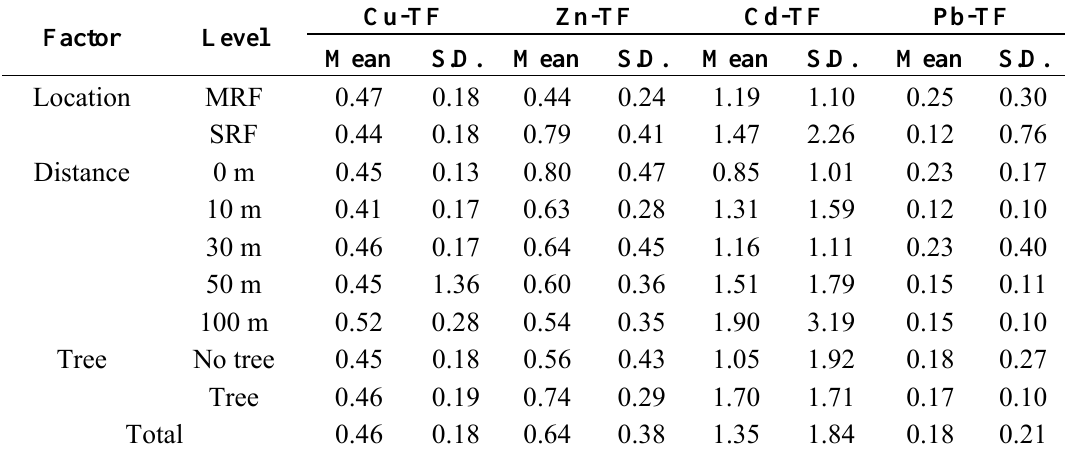
Table 4. Descriptive statistical results of transfer factor of grass-soil heavy-metal concentrations.